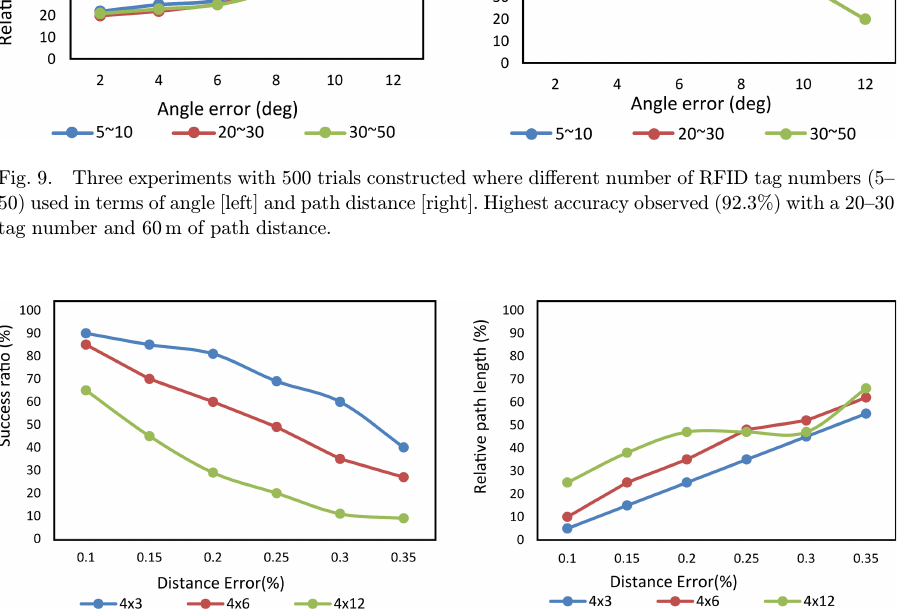
Fig. 10. Three experiments with 500 trials constructed by varying the grid number (4 – 12) in terms of traveled distance. The highest accuracy ð 85 : 3 % Þ observed with 3 – 4 grids and a relative distance of 40m.